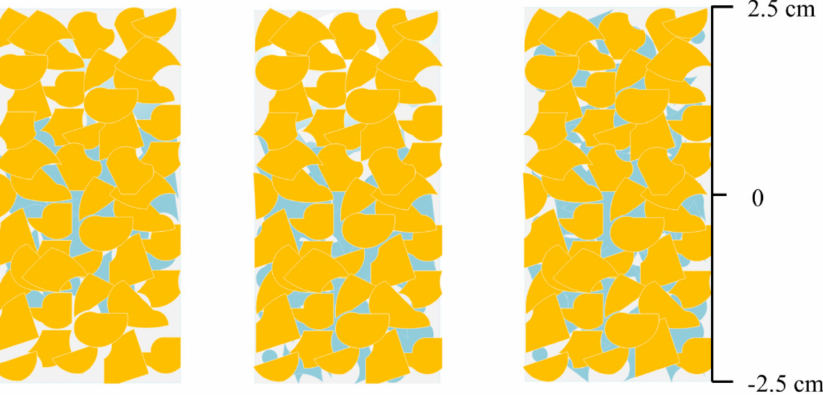
Figure 5. The schematic diagrams of hydrate distribution in three kinds of